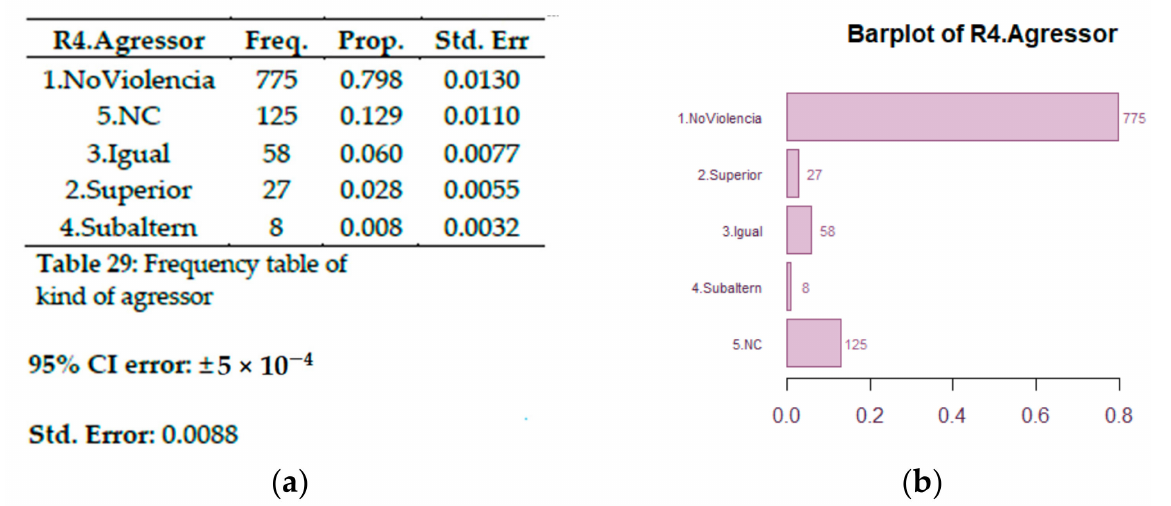
Figure 45. ( a ) Frequency table of kind of aggressor ( b ) Who is the